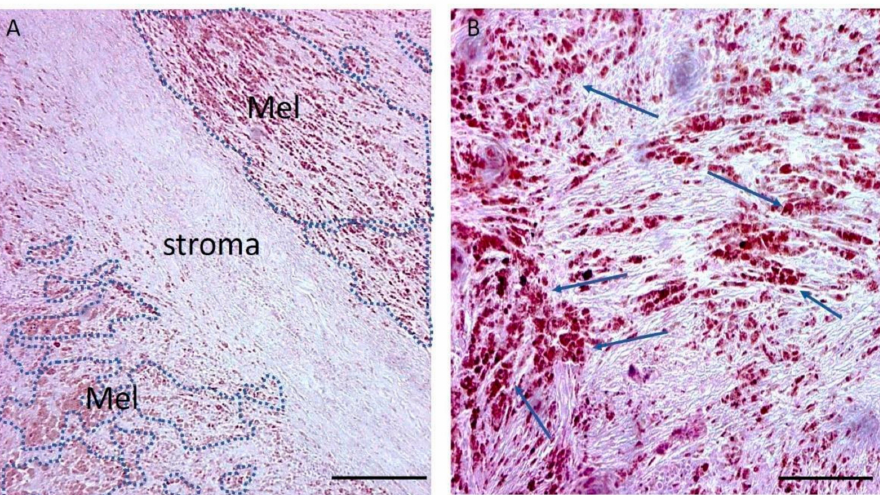
Figure 1. Histopathological microphotograph of a representative melanoma sample . Haematoxylin– eosin staining of a representative melanoma sample showing areas rich in brown-coloured melanin- producing tumour cells (Mel, dashed blue shapes and blue arrows). ( A ) The brown-coloured areas rich in melanocytes are clearly identified by the presence of melanin that is absent in the central portion of the slide (composed of stromal tissue). Scale bar: 200 µ m. ( B ) The higher magnification of this microphotograph allows the observation of melanin-rich cells (indicated by the arrows) and gives information about the cell pleomorphism within the tumour. Scale bar: 50 µ m.